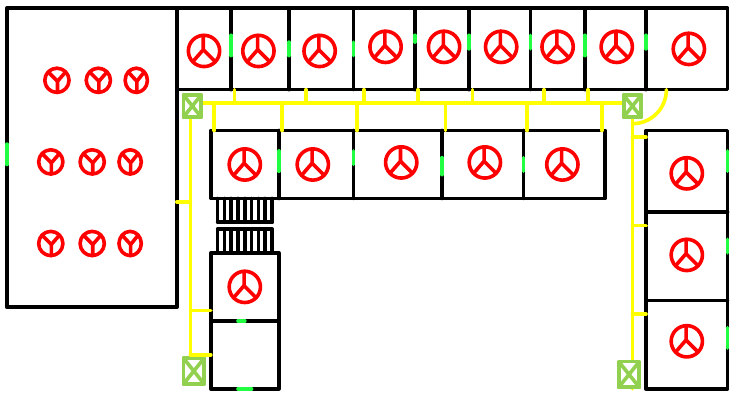
Figure 13. Faqir API Hostel (1st floor) wiring.